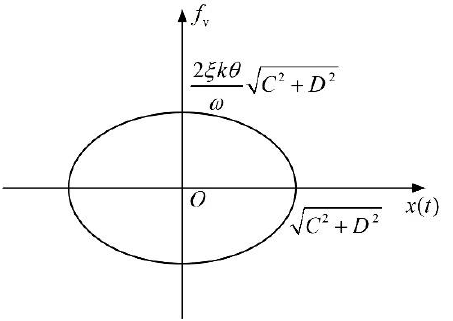
Figure 3. The hysteresis loop of damping force based on viscous damping model. According to Equation (22), the dissipated energy e in each period is related to the excitation frequency based on the viscous damping